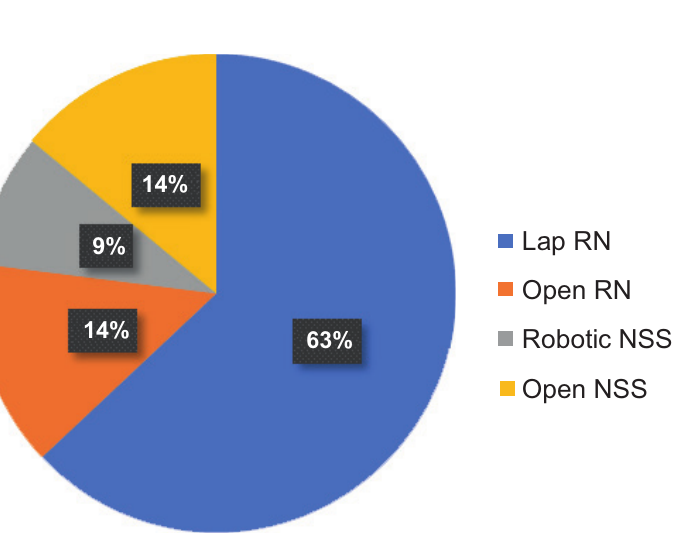
Figure 3: Surgeries.